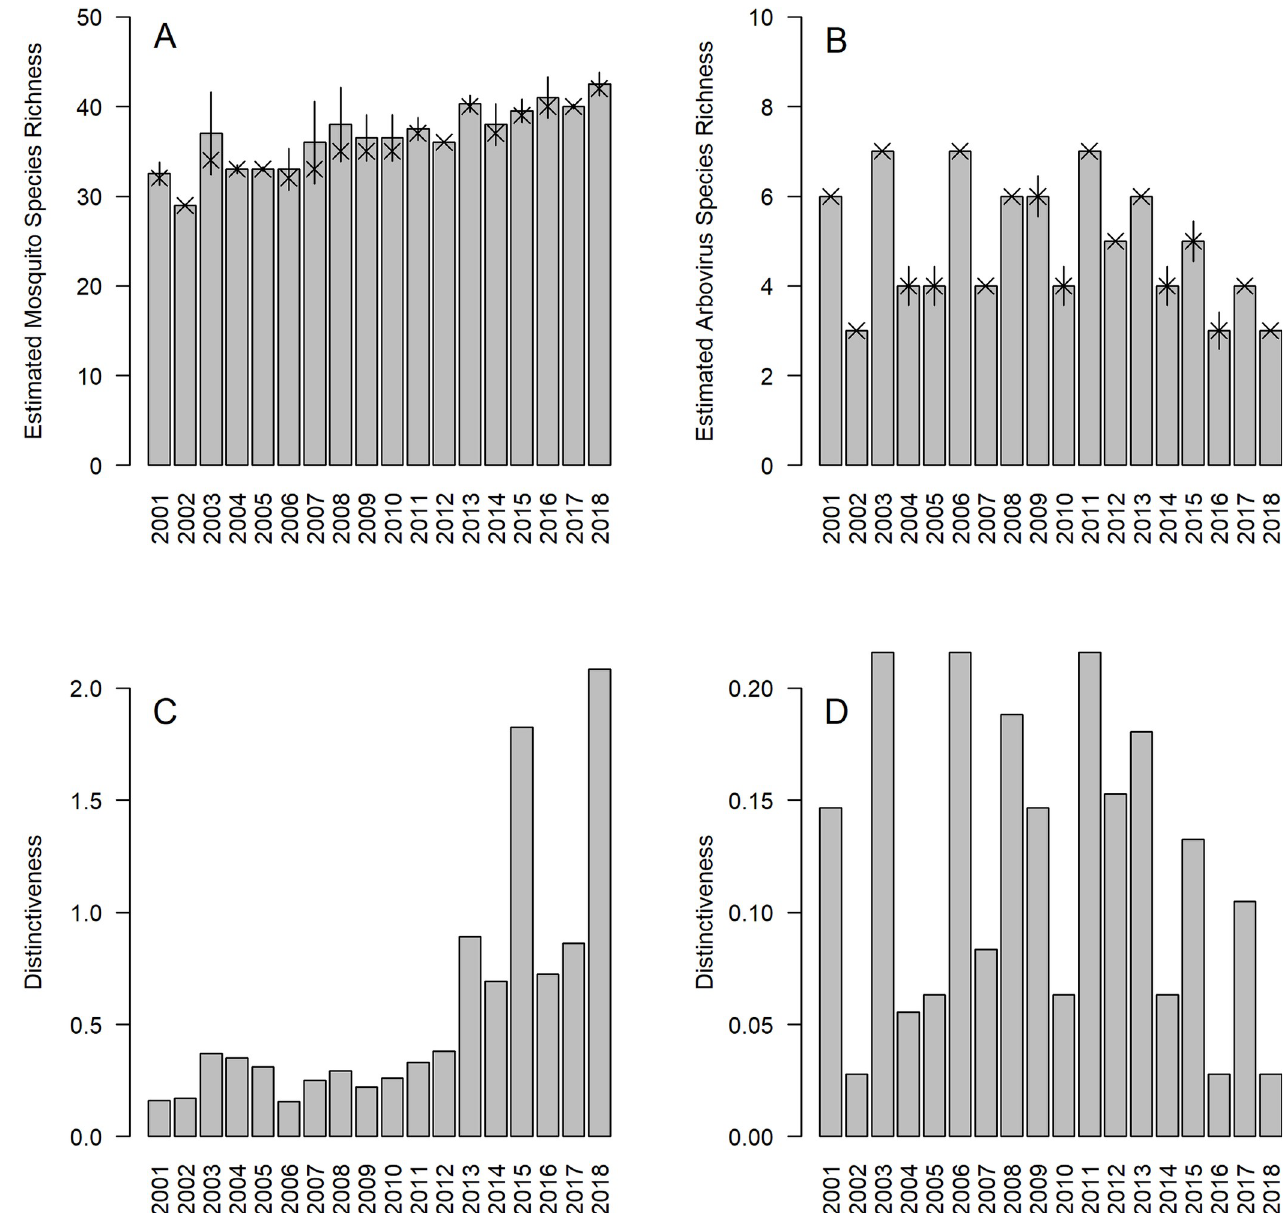
Fig 2. (A and B) Estimated (bars, lines: +/- standard error) and observed (X’s) mosquito species (A) and arbovirus species (B) richness for each year of sampling in Connecticut; (C and D) Year-specific contributions to among unit diversity (i.e., distinctiveness) in mosquito species (C) and arbovirus species (D)